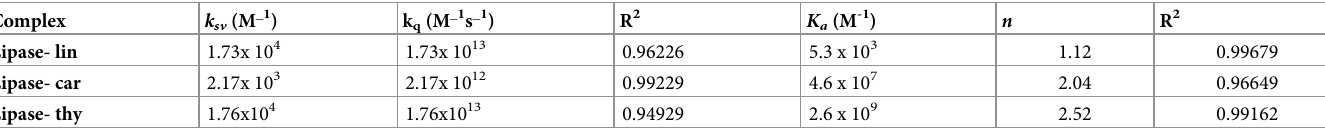
Table 1. Stern–Volmer and quenching constants for lipase biomolecular diffusion-controlled quenching constant, binding constant and number of binding sites at pH 7.4.